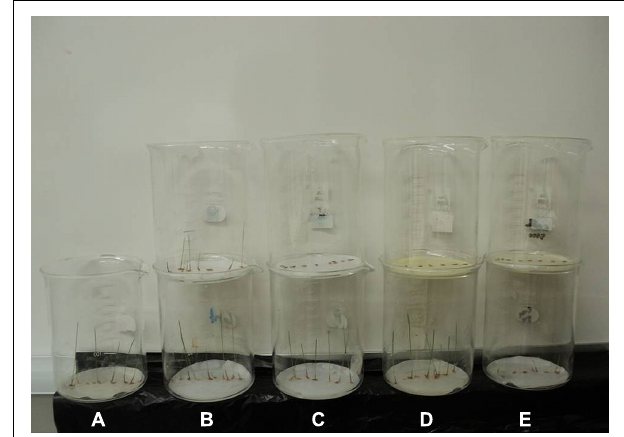
FIGURE 4 | Comparison of the seedlings growth of annual ryegrass affected by (A) control, (B) sinapyl alcohol, (C) p -hydroxybenzoic acid, (D) 3,5,6,7,8-pentahydroxy flavone and (E) their mixture. The beakers in the bottom were treated with low concentration (50 μ M), while beakers on the top were treated with high concentration (10000 μ